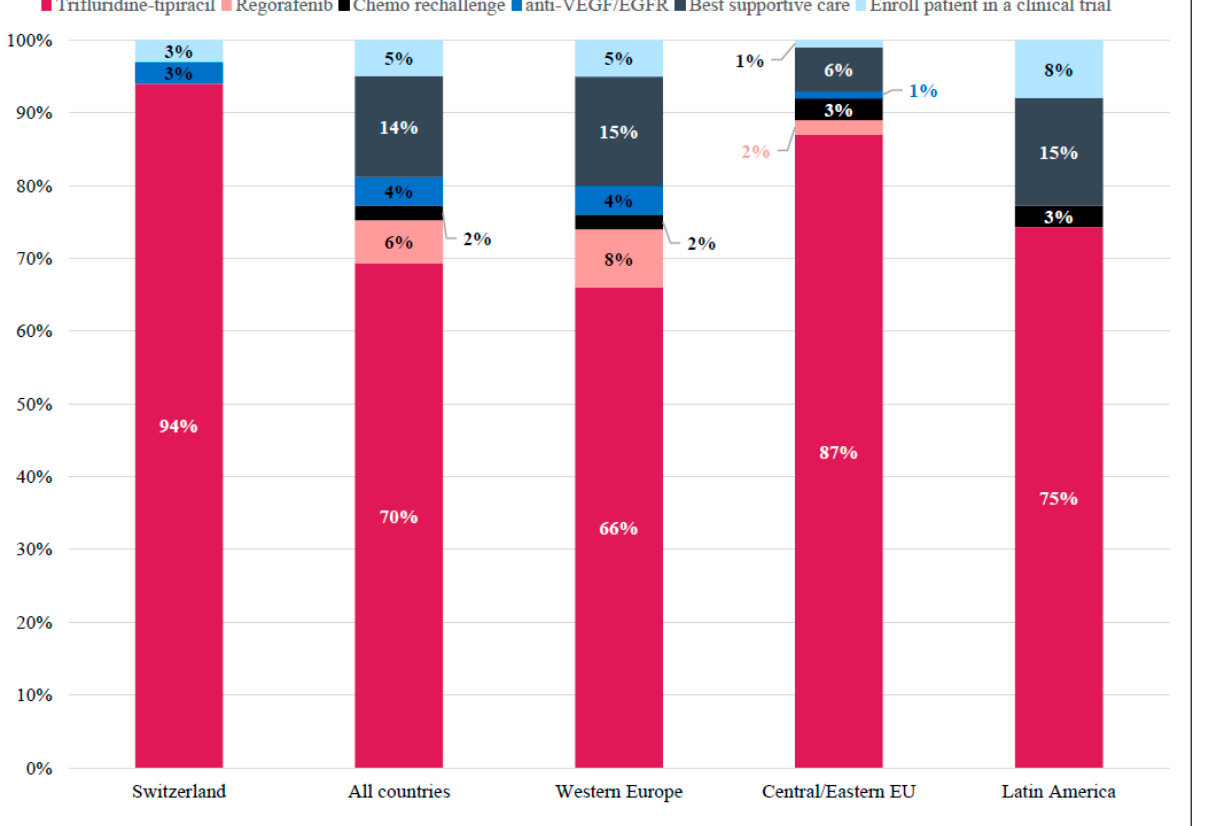
Figure 5. Case 3: Preferred Treatment Choice in the Third-line per Region. Responses for whether trifluridine-tipiracil would be considered a suitable third-line treatment option for a patient with comorbidities, limited support, and difficult hospital accessibility. Shown as percentage of total responses in Switzerland (n = 36), All countries (Western Europe + Central/Easter Eu + Latin America; N = 529), Western Europe (n = 421), Central/Eastern Europe (n = 68), and Latin America (n = 40).